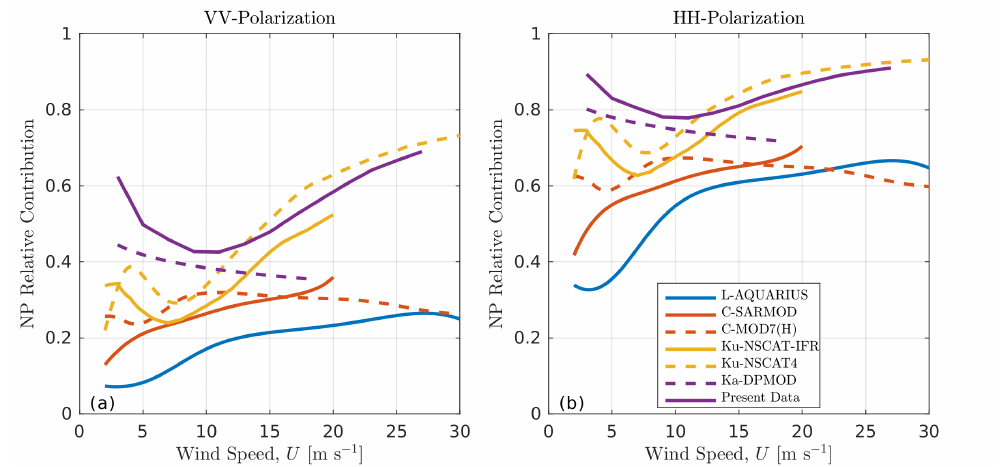
Figure 8. Relative NP contribution versus wind